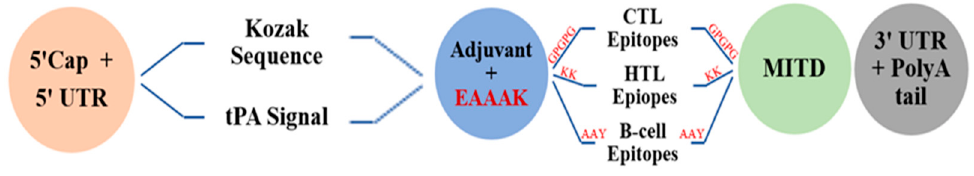
Figure 2. Pictorial description of vaccine construct.